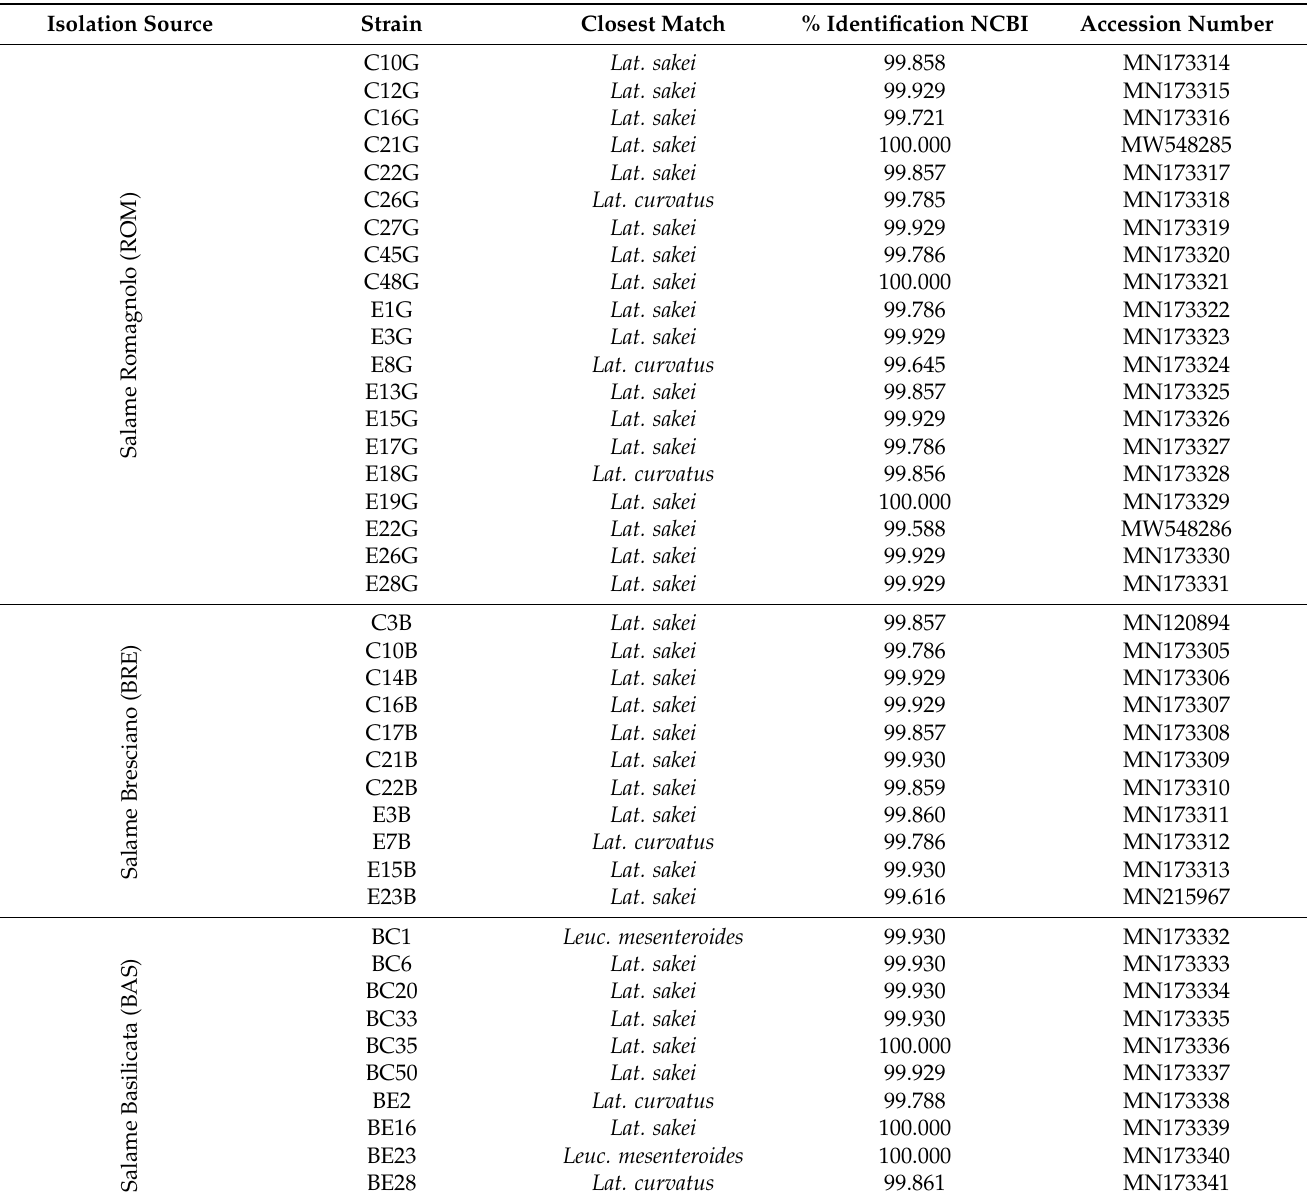
Table 4. Identification of lactobacilli isolated from three spontaneously fermented